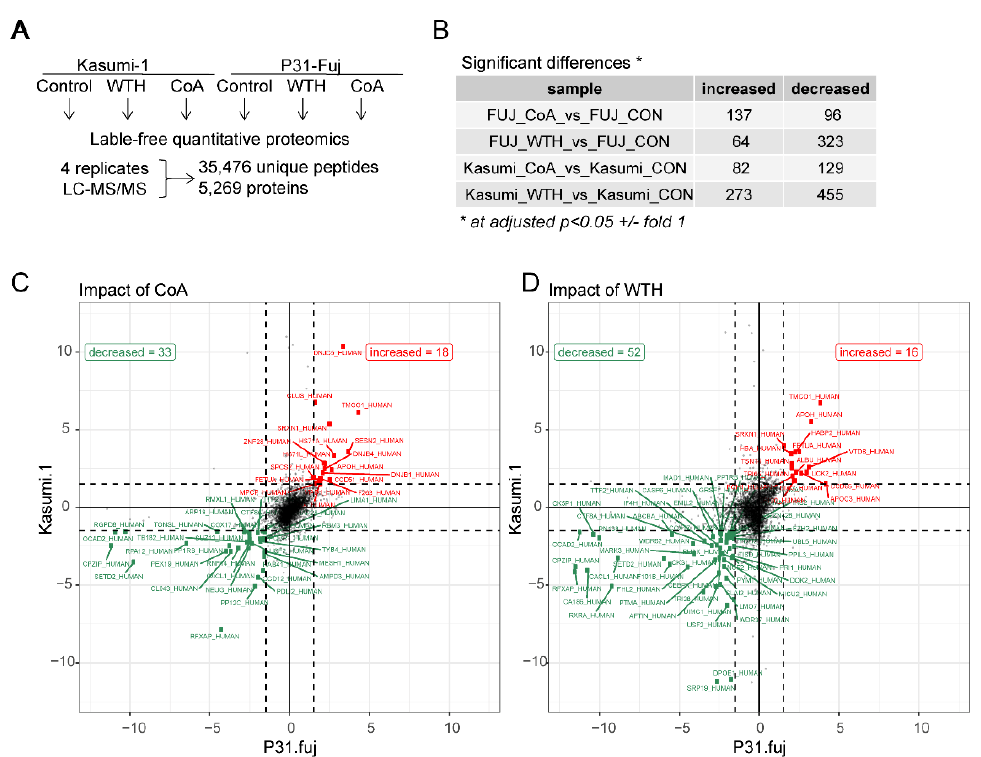
Figure 2. Proteomic analysis of AML cells treated with withanolide metabolites. ( A ) Experimental design and summary of identified proteins. ( B ) Number of proteins increased or decreased as a result of treating the named cell lines with CoA or WTH. ( C , D ) Comparison of protein increased or decreased by CoA ( C ) or WTH ( D ) across the tested cell lines. Proteins increased as a result of treatment are shown as red data points, while decreased proteins are shown are green data points.